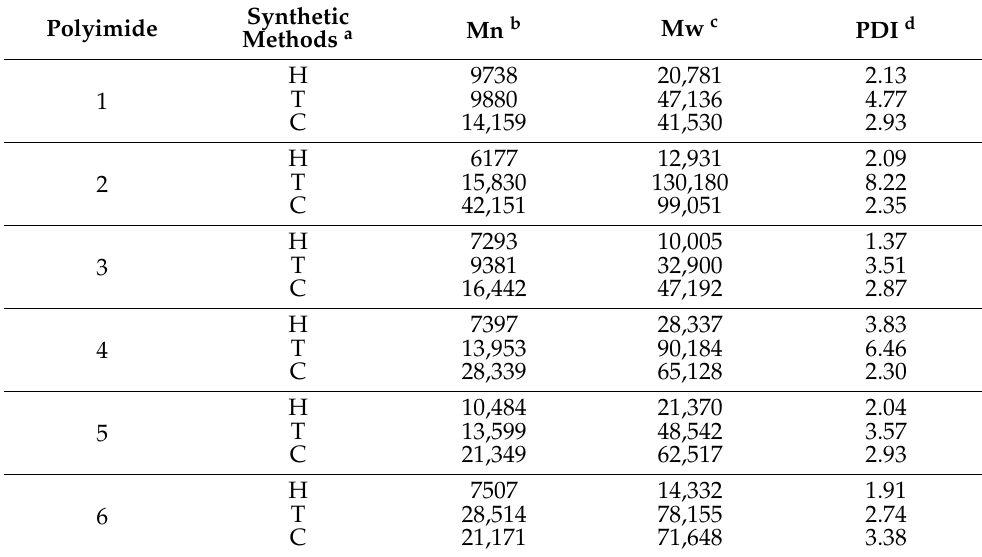
Table 2. Molecular weight and polydispersity index of synthesized polyimides.